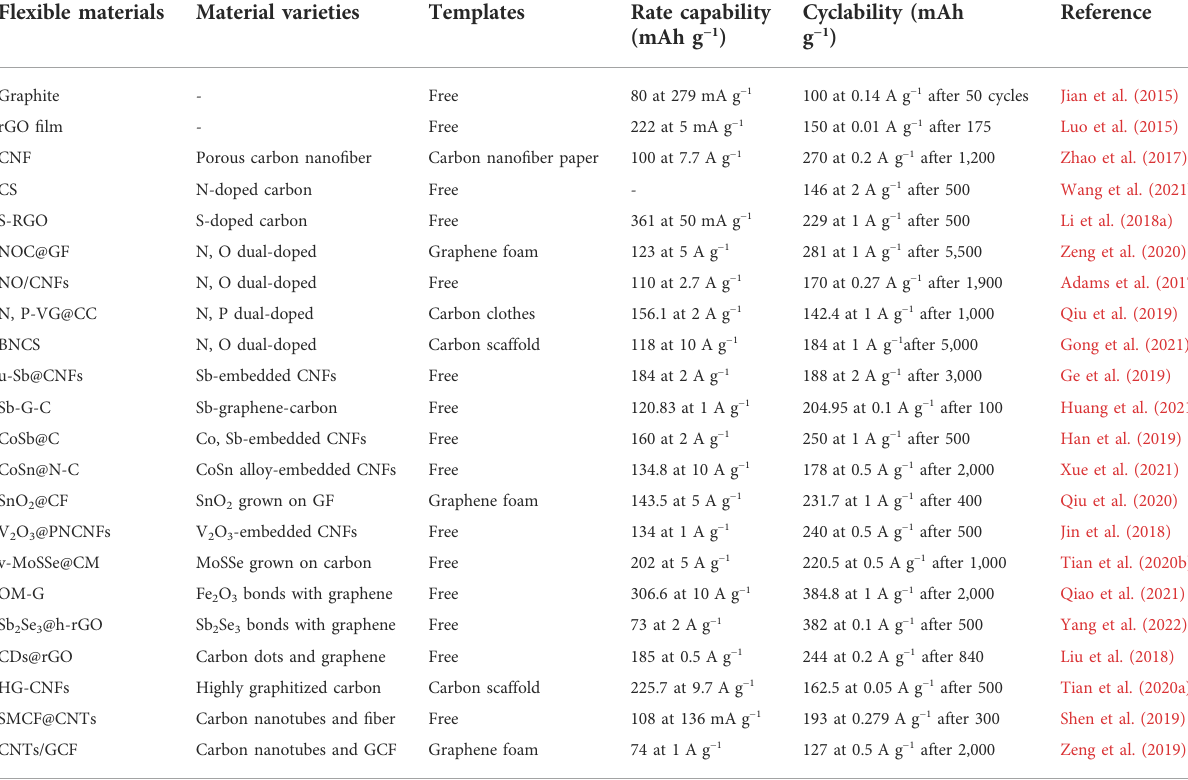
TABLE 1 Electrochemical performance of the various carbon-based fl exible anodes in the study for PIBs. Flexible